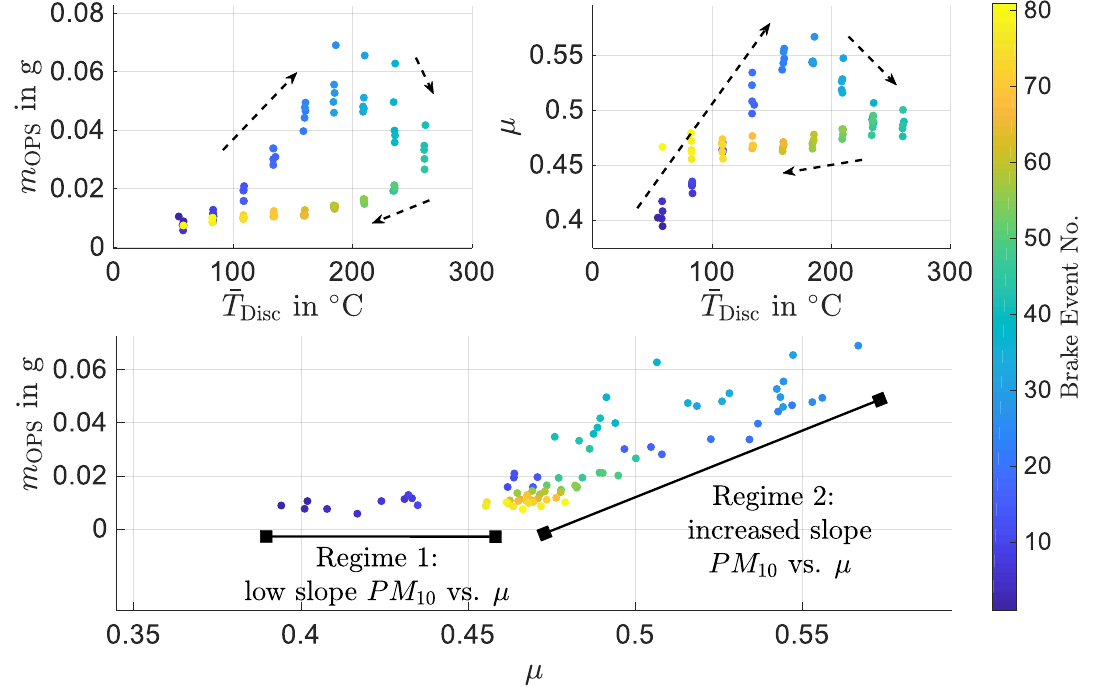
Figure 8. Correlation of PM 10 emission per brake event (calculated by the Optical Particle Sizer (OPS) size distribution and a density of 3.5 g/cm³), average disc temperature T per brake event, and the coefficient of friction µ for the pad material with an organic binder.